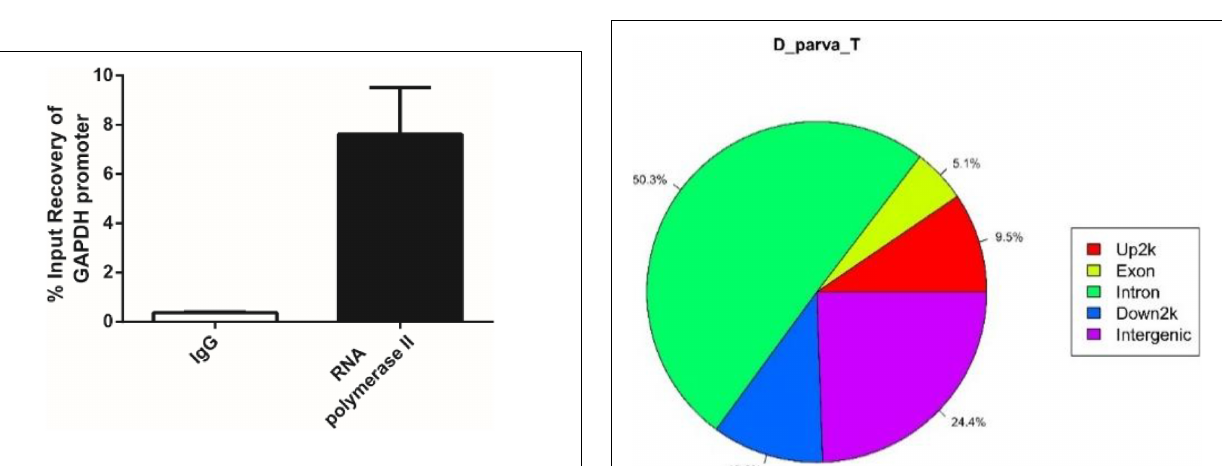
FIGURE 4 | The negative control and positive control for ChIP experiment. Data are the averages ± SD of three replicates. Normal rabbit IgG was used as a negative control. Anti-RNA polymerase II antibody was used as a positive control. The promoter of GAPDH gene from D. parva was used as the target in the controls for ChIP experiment.